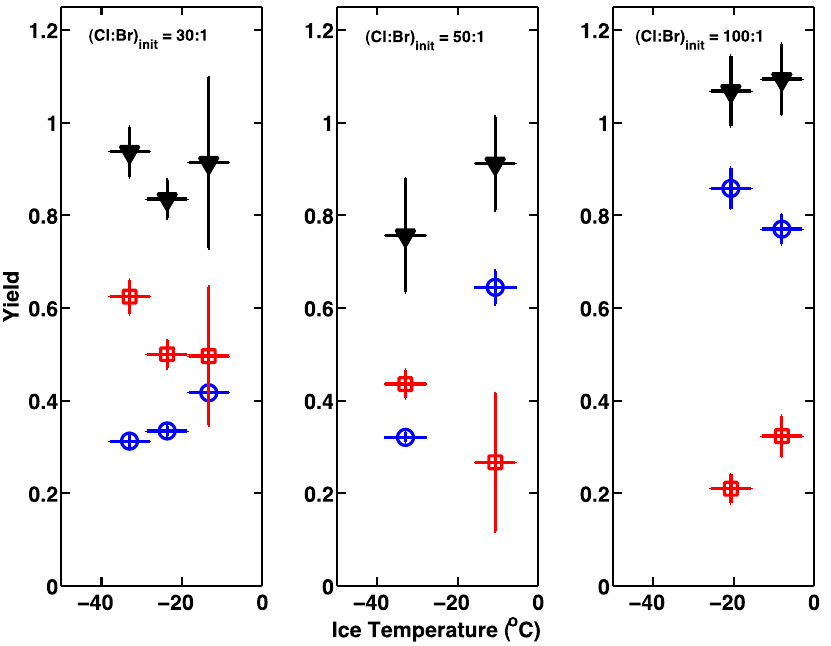
Fig. 6. Halogen product yields are plotted versus ice temperature for three different starting solutions. The vertical error bars represent the 1 σ deviation of the yields from multiple determinations and the horizontal error bars are ± 5K (see methods) representing the estimated ice temperature accuracy. The initial solutions are synthetic seawater with additional bromide to enhance the starting Cl:Br mole ratio to be 100:1, 50:1, and 30:1. Cooling the ices formed from the various initial solutions below the temperatures at which precipitation of NaCl2H 2 O and MgCl 2 12H 2 O occurs led to enhanced production of Br 2 beyond that expected from the initial Cl:Br ratio. This result is consistent with a decrease in the Cl:Br ratio of the brine layer due to precipitation of the chloride containing salts at temperatures below 250K.